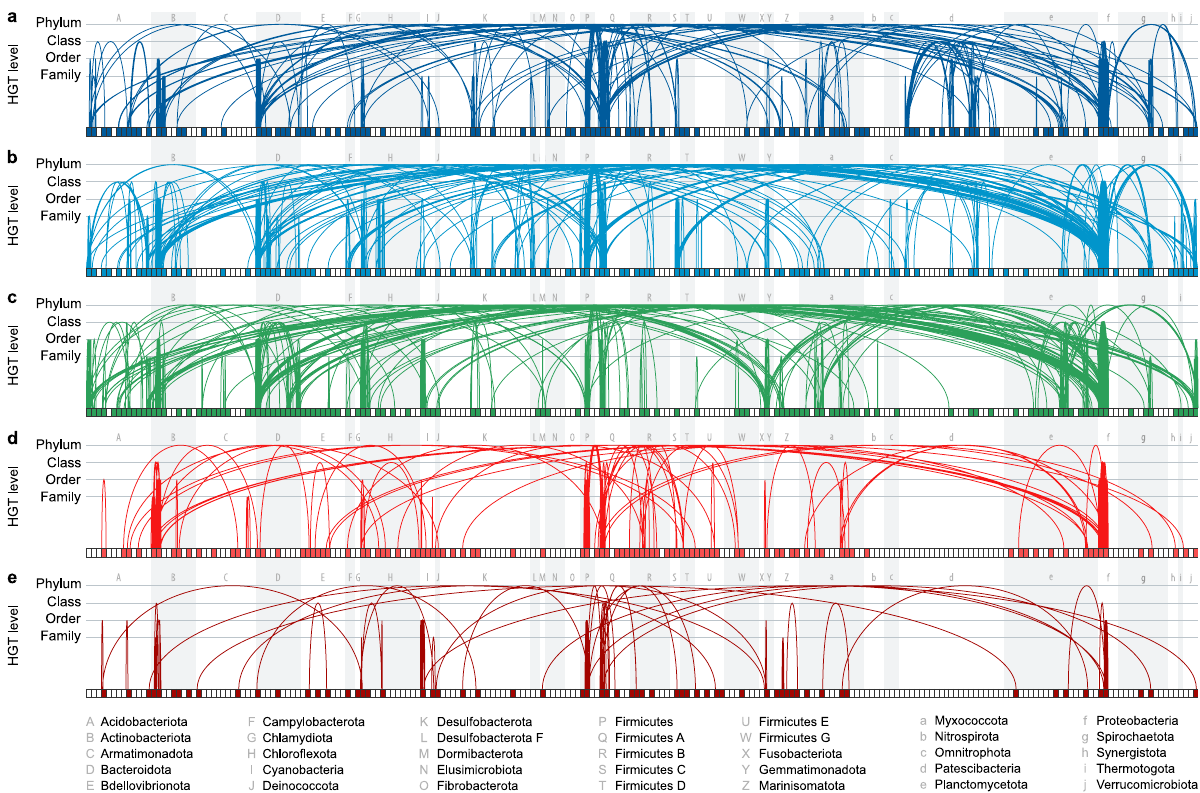
Figure 3. Putative horizontal gene transfer events of l-asparaginases in bacteria. HGT events of the five AI-AV l-asparaginase types ( a–e , respectively) across 223 classes of bacteria belonging to 35 most abundant phyla. Rectangles represent classes of bacteria and mark the presence (filled with color) or absence (white) of a given l-asparaginase type in a given class. Arcs show horizontal gene transfer between two bacterial species. The height of the arcs marks the highest taxonomic rank that is different between the species (i.e., phylum, class, order, family). Arc widths are arbitrary and do not represent any taxonomic or evolutionary distance between